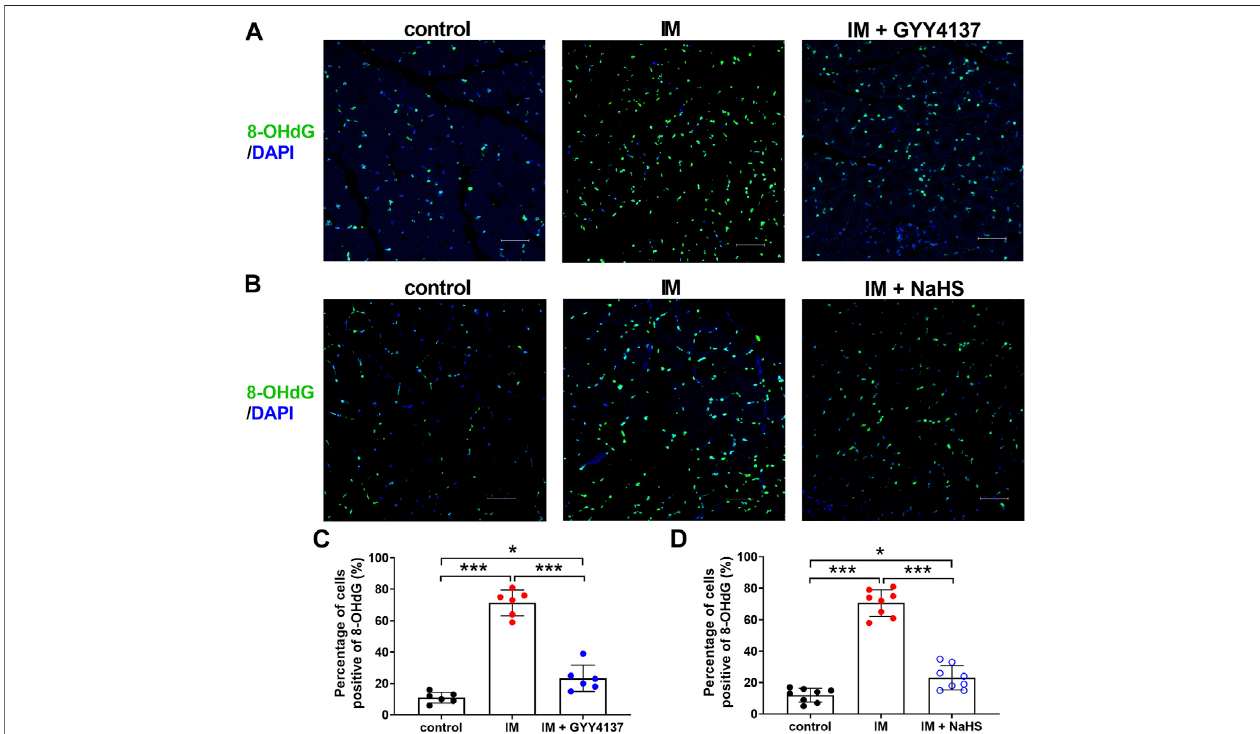
FIGURE 8 | H2S donors attenuate the IM-induced muscle 8-OHdG positive staining. Mice were subjected to IM and treated with GYY4137 (a and c, 50 μ g/kg/d, ip), or NaHS (b and d, 1.12 mg/kg, twice a day, ip) for 2 weeks. The control and IM groups received identical doses of saline for 2 weeks. (A) and (B) , Representative micrographs of 8-OHdG staining in TA muscles (Scale bar, 50 μ m). (C) , Quantitative analysis of 8-OHdG positive staining of TA muscles in control, IM, and IM + GYY4137 mice (n = 6 in each group). (D) , Quantitative analysis of 8-OHdG positive staining TA muscles in control, IM, and IM + NaHS mice (n = 8 in each group). Data represent means ± SEM. * p < 0.05, ** p < 0.01, *** p < 0.001.